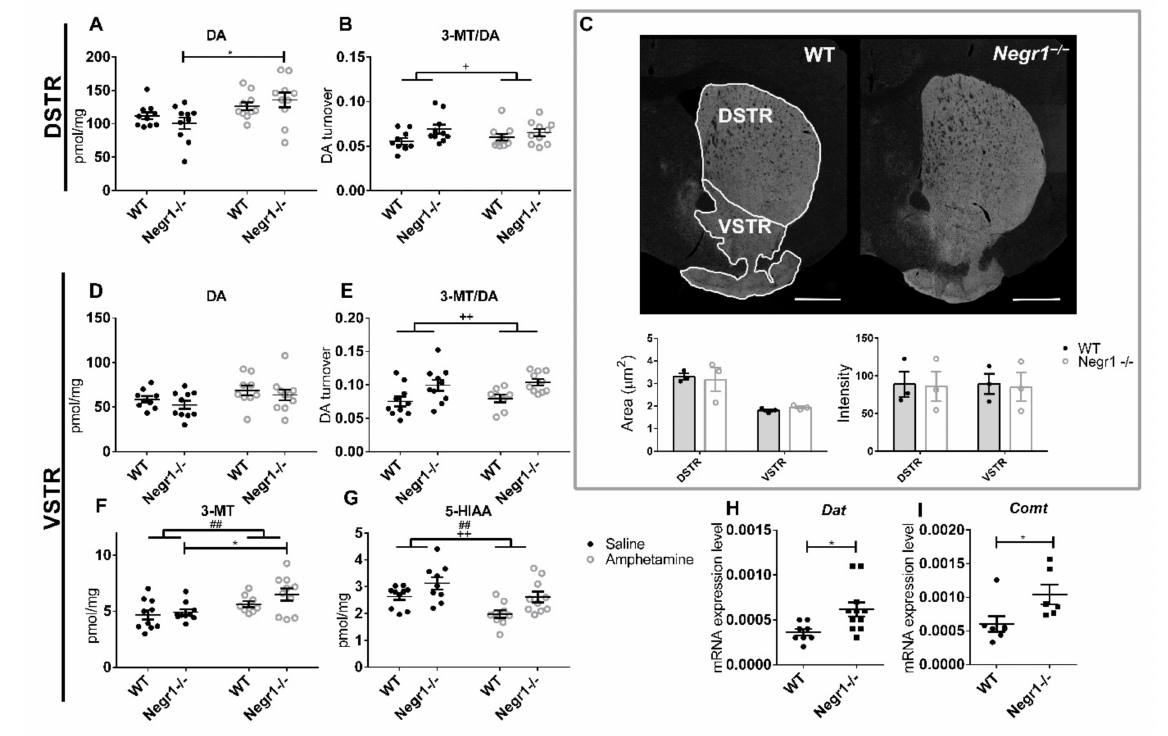
Figure 4. Effect of chronic amphetamine in the dorsal striatum (DSTR) and ventral striatum (VSTR). The level of ( A ) dopamine (DA) and ( B ) dopamine turnover (3-MT/DA) in the DSTR. ( C ) Immunohis- tochemical DAT stainings of DSTR and VSTR. The level of ( D ) dopamine (DA), ( E ) dopamine turnover (3-MT/DA), ( F ) 3-MeOTyramine (3-MT), ( G ) 5-Hydroxyindoleacetic acid (5-HIAA), ( H ) dopamine transporter ( Dat ), and ( I ) catechol- O -methyltransferase ( Comt ) in the VSTR. Data represent mean ± SEM, ## p < 0.01—treatment effect, + p < 0.05, ++ p < 0.01—genotype effect, * p < 0.05—post hoc test, ordinary two-way ANOVA (Bonferroni post hoc test), Mann–Whitney U test ( H , I ), WT –